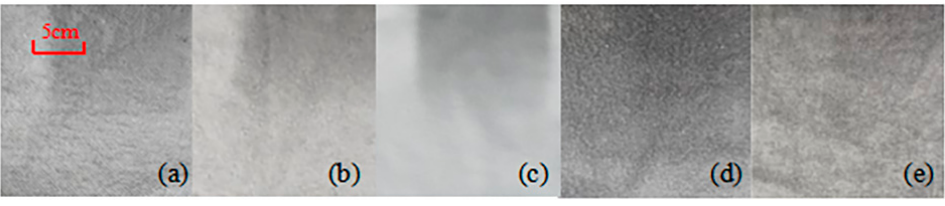
Figure 6. Real-world fabric samples.